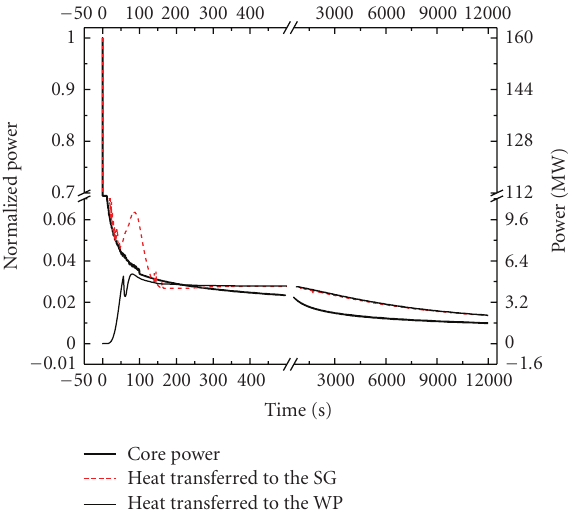
Figure 5: Decay power and heat transferred in the SG and PRHRS.